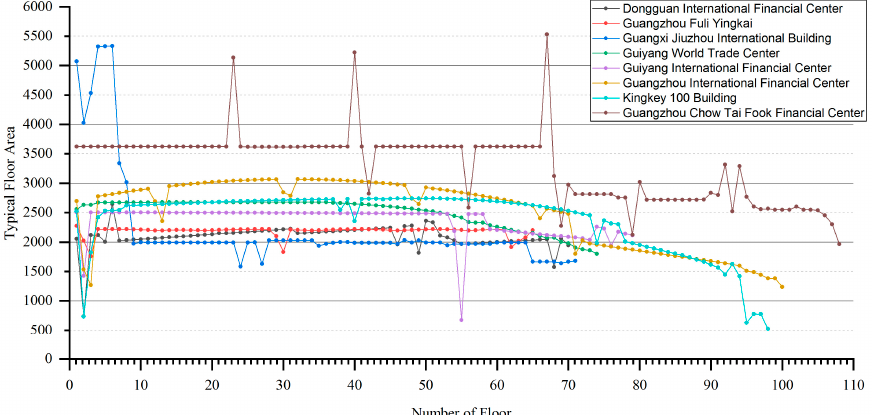
Figure 9. Variation of typical floor area in the studied high-rise buildings.